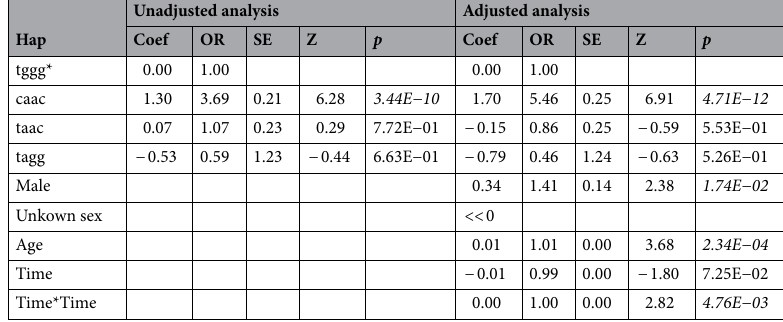
Table 4. Replication results of (t19839-g28881-g28882-g28883) with hospitalization status (inpatient and outpatient) in a case–control study of 476 outpaitents and 488 inpatients: estimated coefficients, standard error, Z-score and p -value across three haplotypes, from the marginal and adjusted analysis. Adjusted analysis controled sex, age, collection time and its square (to account possible non-linear time effect). *"tggg" is treated as a reference haplotype for comparison with other haplotypes.